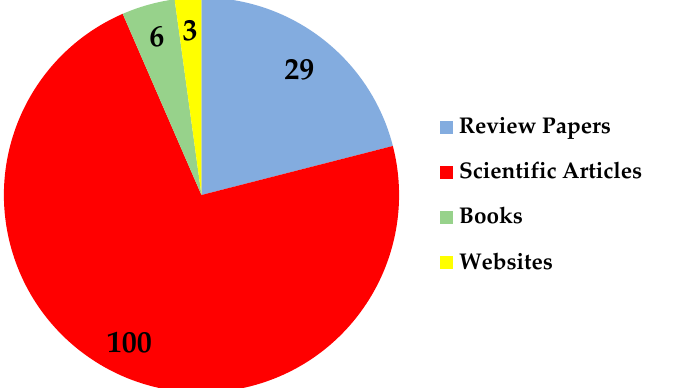
Figure 2. Distribution of documents analyzed for realizing the survey of haptic technologies.